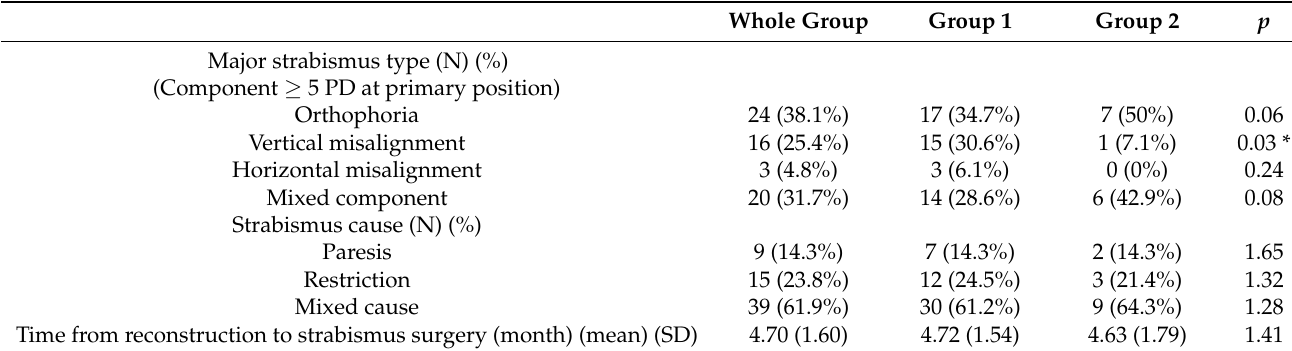
Table 2. Detailed preoperative patient strabismus